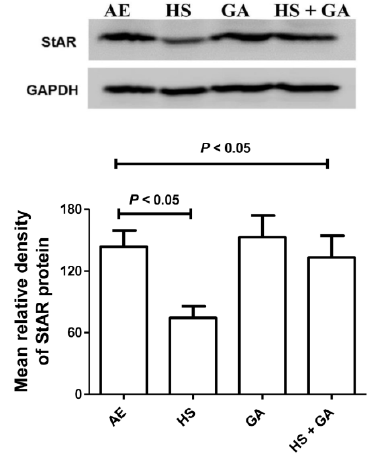
Figure 8. Representative immuno-Western blot of testicular StAR protein in control and hookah